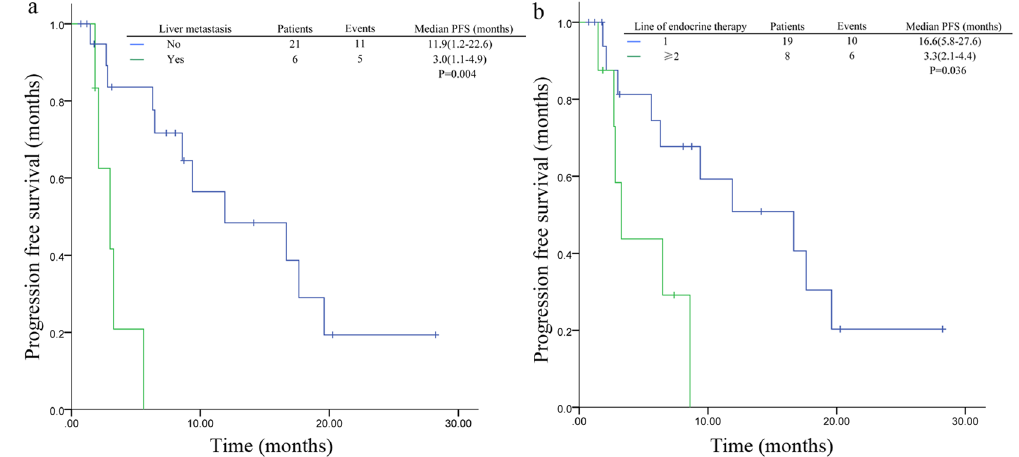
Figure 1. Kaplan–Meier curves for progression-free survival in patients with different tumor characteristics. ( a ) For patients stratified by liver metastasis. ( b ) For patients stratified by line of endocrine therapy. Abbreviations: CI, confidence interval; PFS, progression-free